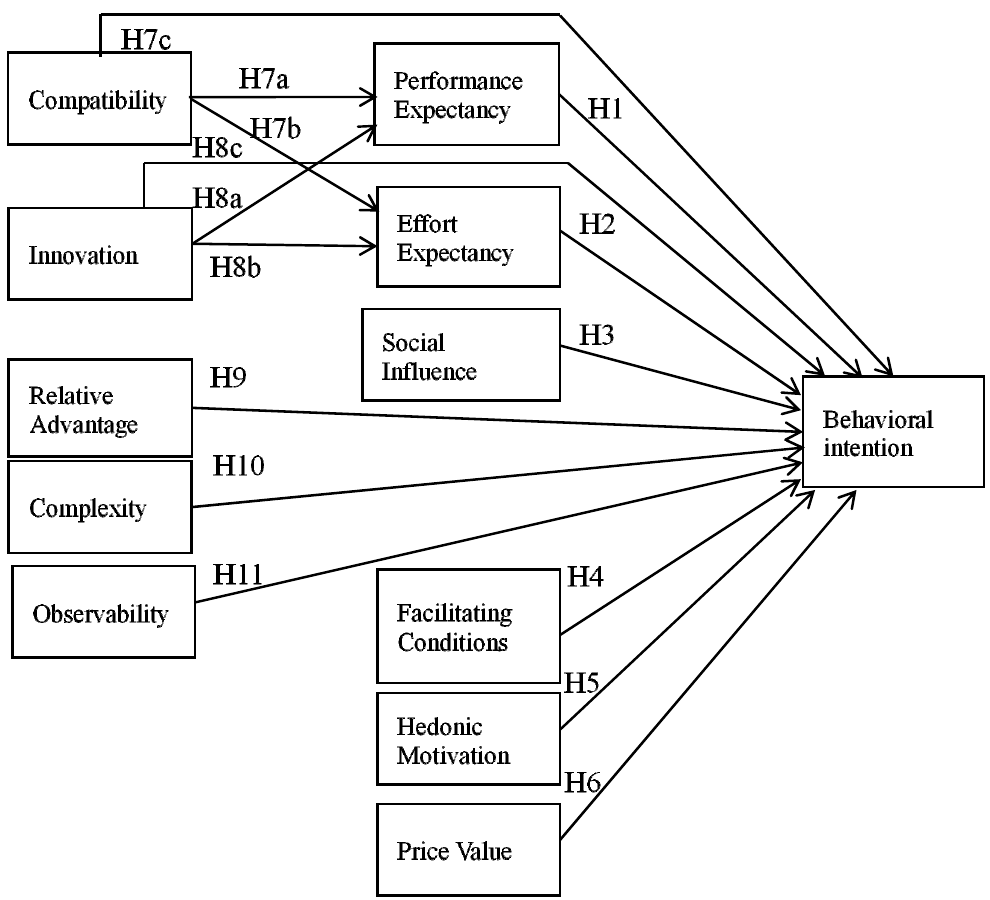
Figure 2. Research Figure 2. Research framework.